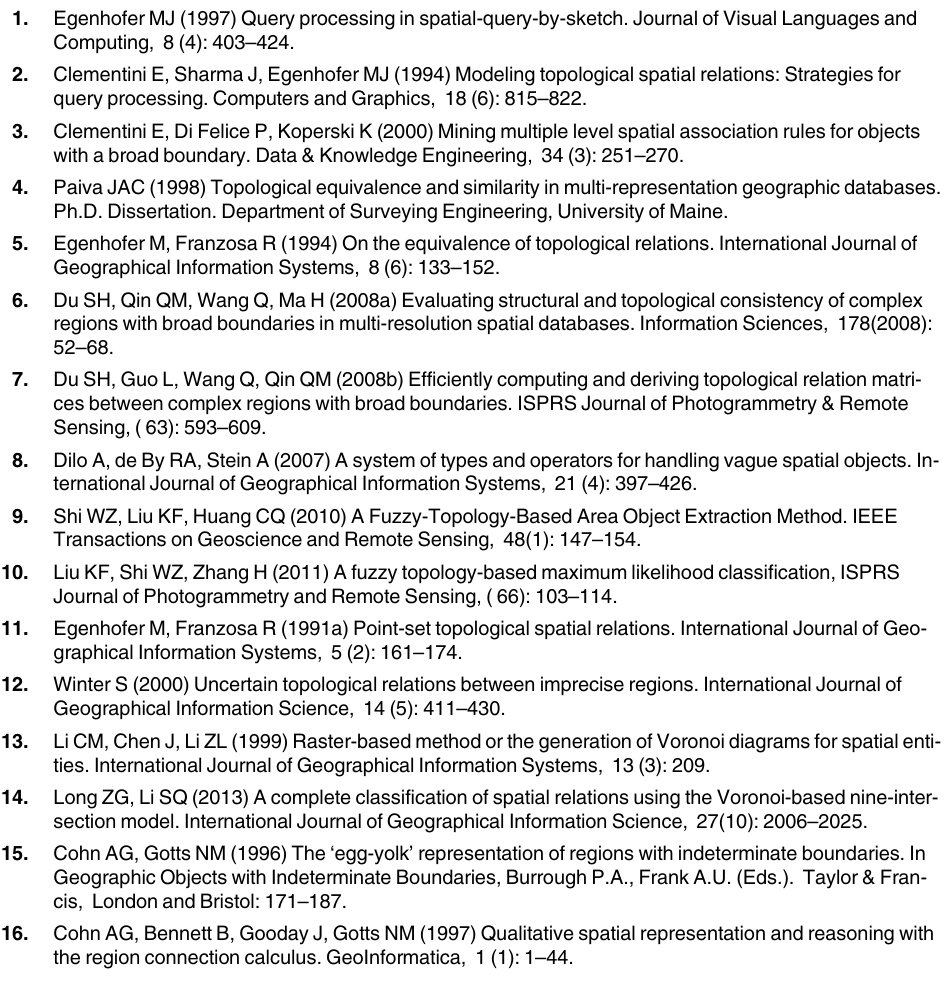
S1 Table. The 23 relations between a simple crisp region and a simple fuzzy region in R 2 . (PDF) S2 Table. The 152 relations between two simple fuzzy regions in R 2 .